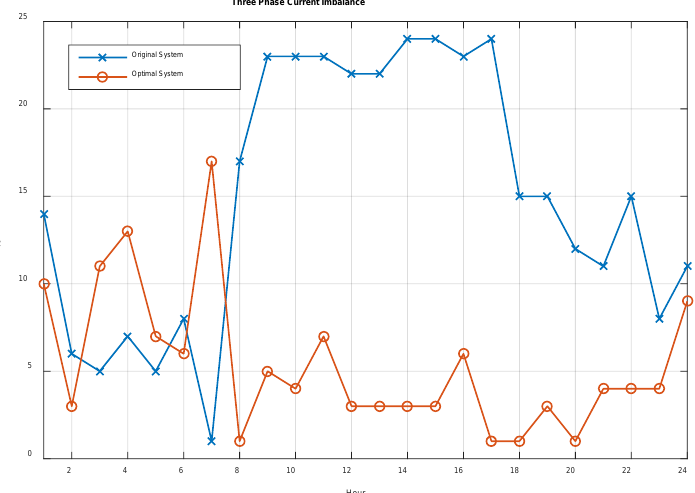
Figure 8. The daily system unbalance profiles at the swing bus (bus 1).